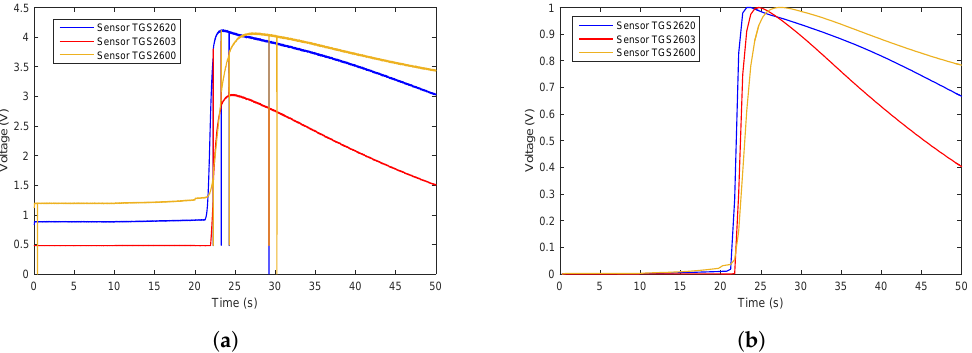
Figure 8. Time series of rotten meat odor raw data and the data after preprocessing. ( a ) Shows the representative example of the time series of the original response curves of the sensor array for the odor from rotten meat. ( b ) Shows the results after preprocessing.